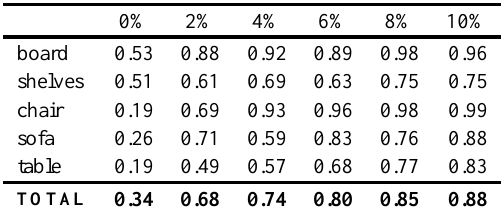
Table 2. Evaluation of accuracy by class according to the percentage of point cloud images in the training set with online images in the validation set.